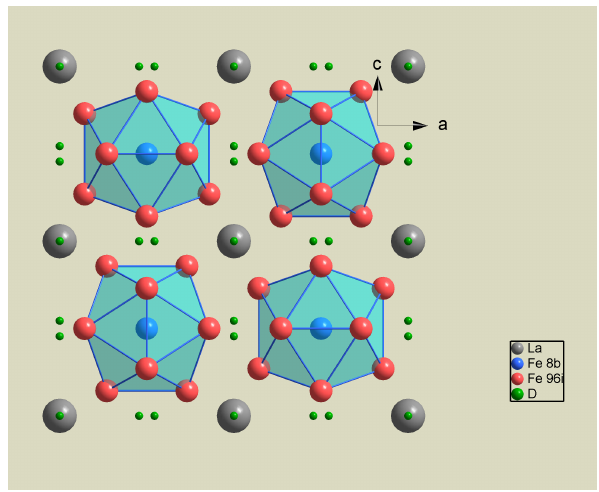
Figure 11. The unit cell of LaFe 11.5 Si 1.5 D 0.7 projected along the ( a , c ) plane.